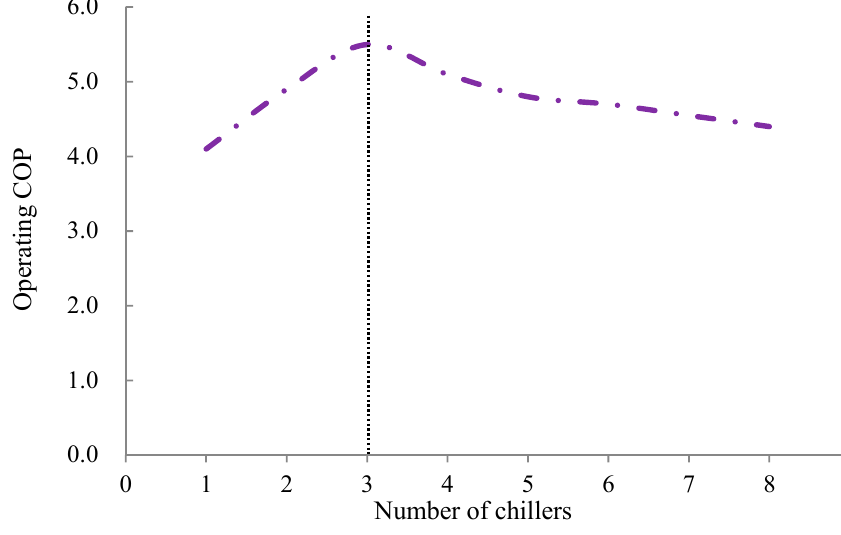
Figure 6. COP vs. number of chillers.